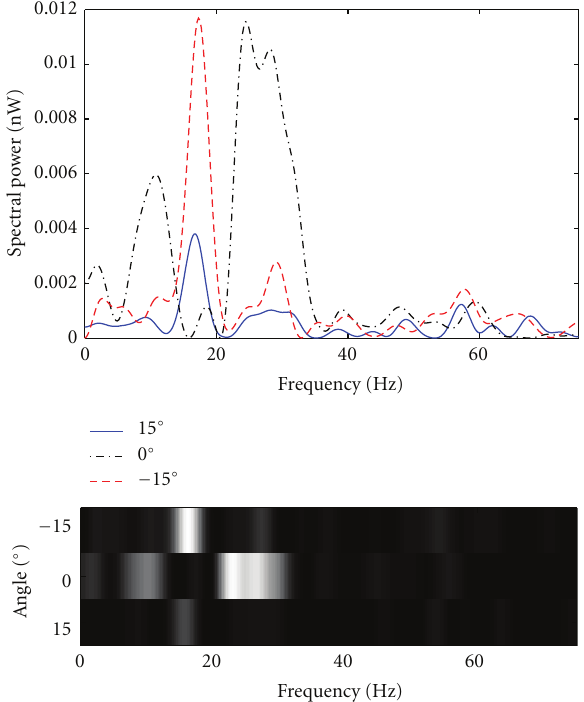
Figure 10: Spectrogram for a person walking towards the radar at a 0 ◦ angle and a speaker placed at − 15 ◦